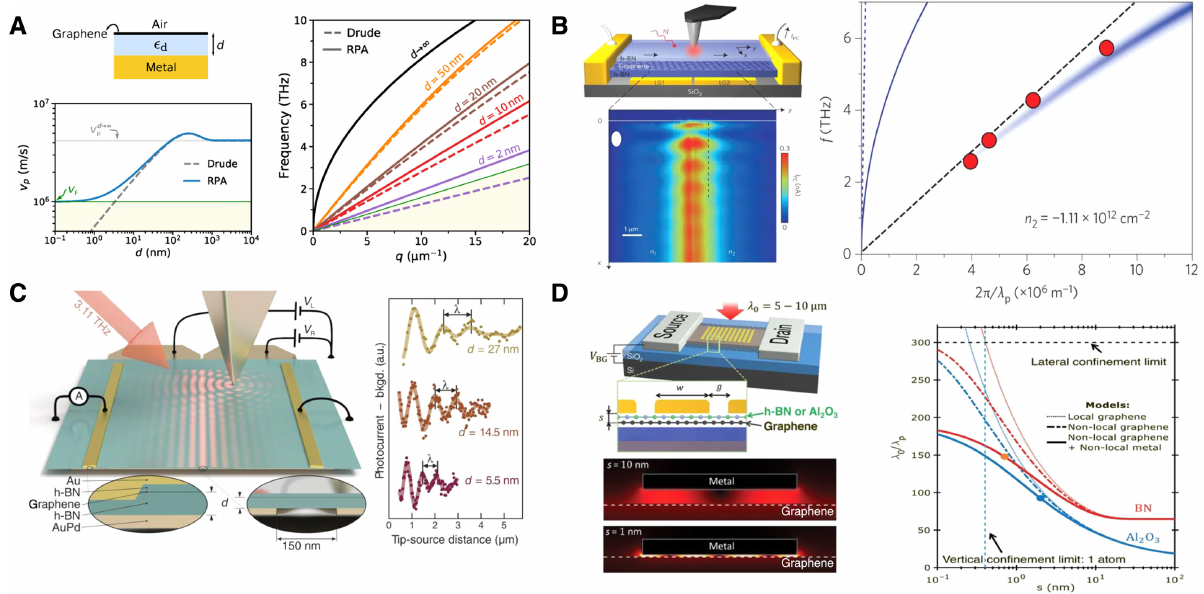
Figure 5: Ultrastrong light–matter interactions enabled by acoustic plasmons. (A) Plasmon velocity v and dispersion curves of acoustic graphene plasmons supported by a graphene-dielectric-metal system as a function p of the thickness d of the dielectric separating a graphene layer from a metal substrate. Both the local and nonlocal responses for AGP are considered, whereas the metal is assumed to be a perfect electric conductor. (B) Left, Schematics of the experimental setup and real-space imaging of acoustic graphene plasmons in a graphene photodetector with split-gate architecture, where the laser-illuminated metal tip of an atomic force microscope serves as a nanoscale near-field light source. Right, The dispersion of AGPs obtained by s-SNOM, see the red symbols, showing a nearly linear dispersion at low frequencies. (C) Left, Schematics of the experimental setup, where terahertz laser illuminates the device, launching the AGP. Right, Photocurrent profiles for three different devices and their corresponding plasmon wavelength λ . (D) Left, Device design for probing ultimate confinement limit for AGP and simulated plasmonic fields for the separations at 10 and 1 nm. Right, Simulated plasmon wavelength as a function of metal–graphene separation under four different models. Reproduced/adapted with permission from Gonçalves et al. [57] (A), Alonso-González et al. [117] (B), Lundeberg et al. [118] (C), and Alcaraz Iranzo et al. [119]